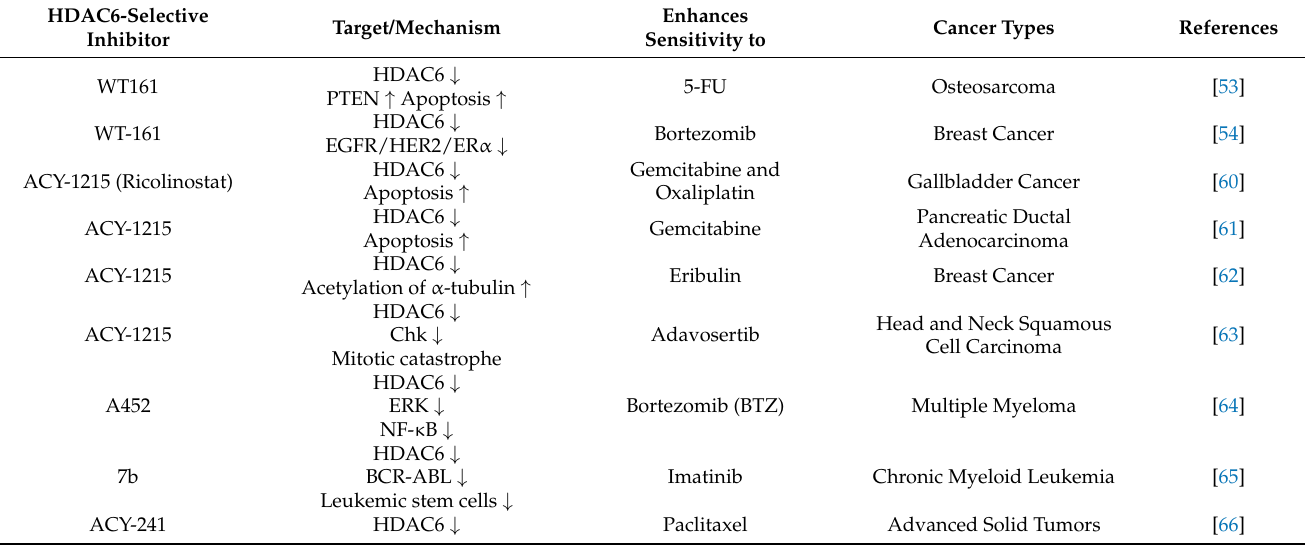
Table 3. HDAC6-selective inhibitors overcome resistance to anti-cancer